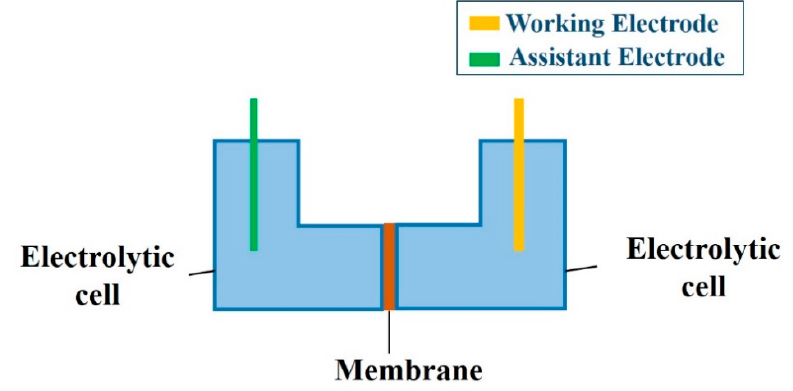
Figure 2. The experimental setup for electrochemical impedance spectroscopy (EIS) measurement.